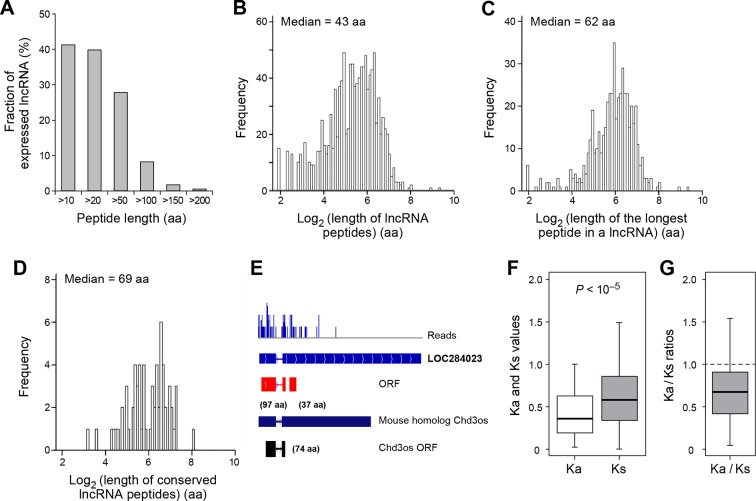
Features and conservation of lncRNA peptides.(A) Fraction of expressed lncRNAs that encode peptides longer than a certain length. (B) Peptide length encoded by lncRNAs. (C) Length of the longest peptide in a given lncRNAs. (D) Length of conserved lncRNA peptides. (E) LncRNA LOC284023 encodes two peptides, the upstream one being conserved in the mouse lncRNA Chd3os. (F) Ka and Ks values of types of conserved lncRNA peptides with Z-Test p-values shown. (G) Ka/Ks ratios of types of conserved lncRNA peptides.